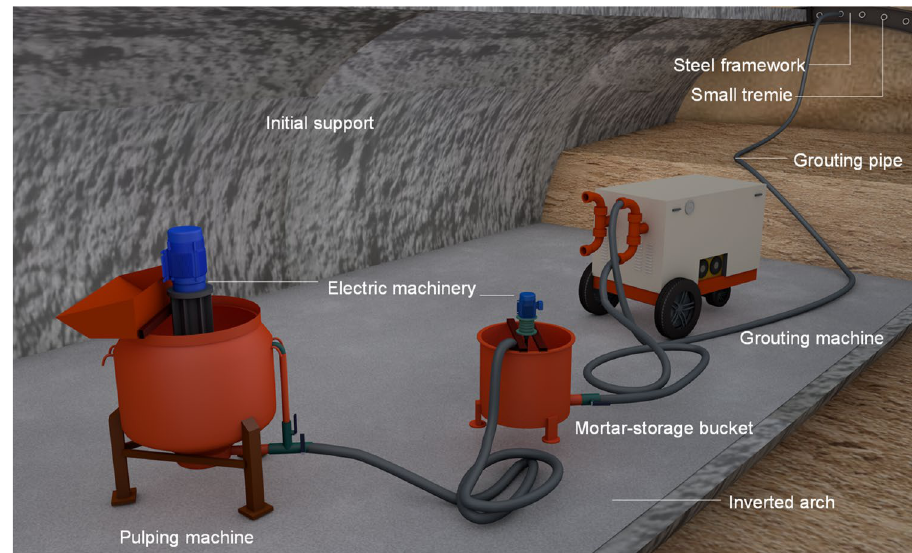
Figure 4. Sketch map of grouting inside the